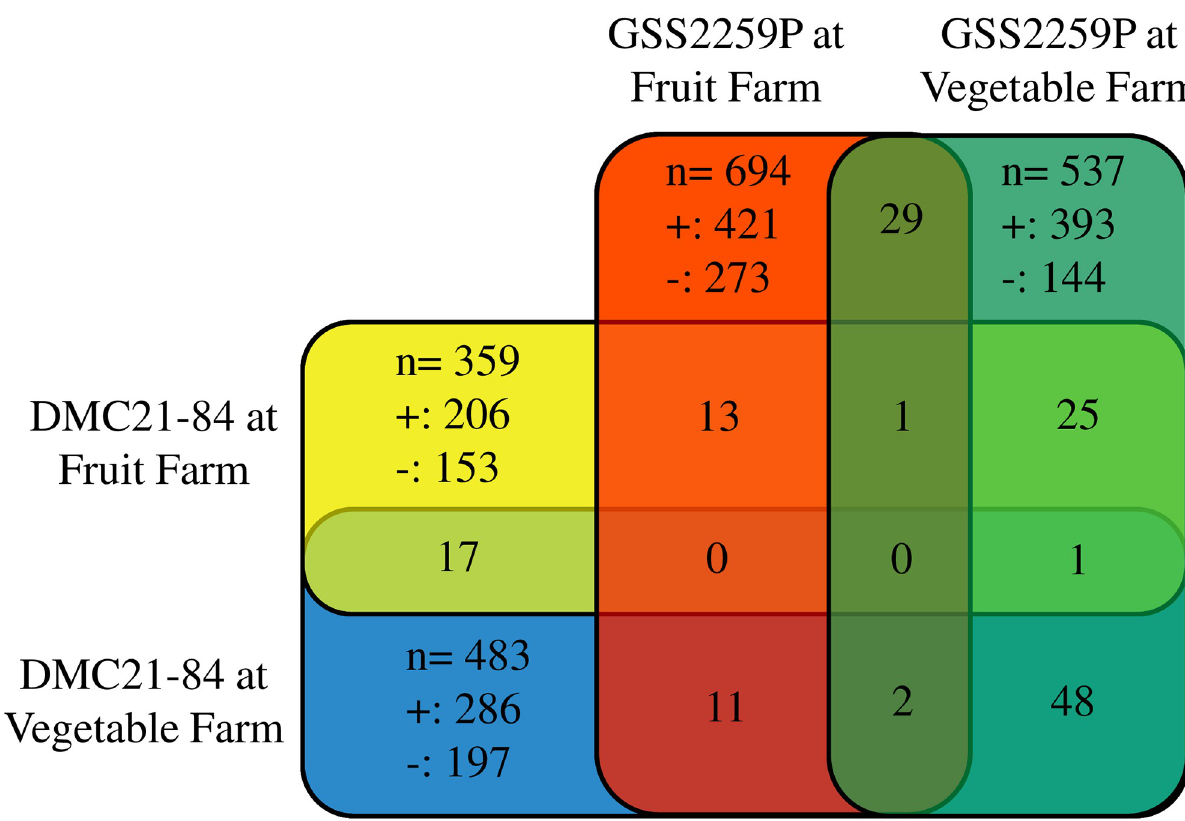
Fig 2. Number of DEGs identified in pairwise comparisons between low and high plant density for each hybrid and site combination (p-value < 0. 01). Plus and minus sign represents number of DEGs with up- and down-regulation, respectively. Number of DEGs identified two or more hybrid and site combinations is shown where the combinations